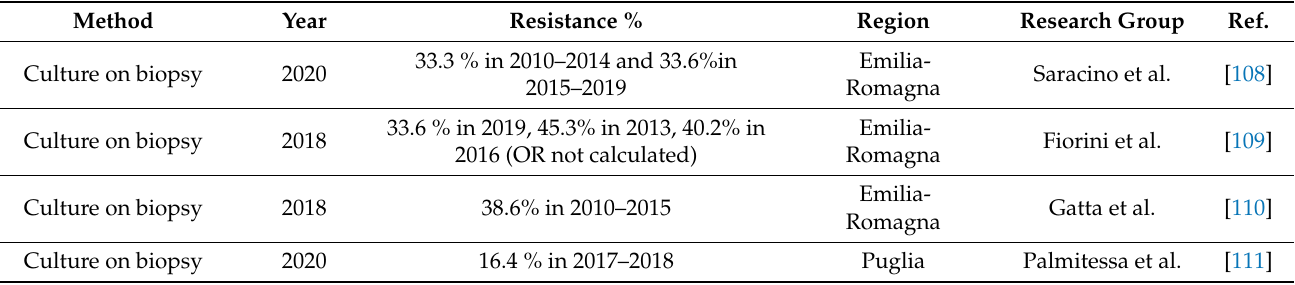
Table 3. Primary metronidazole resistance in Italy.